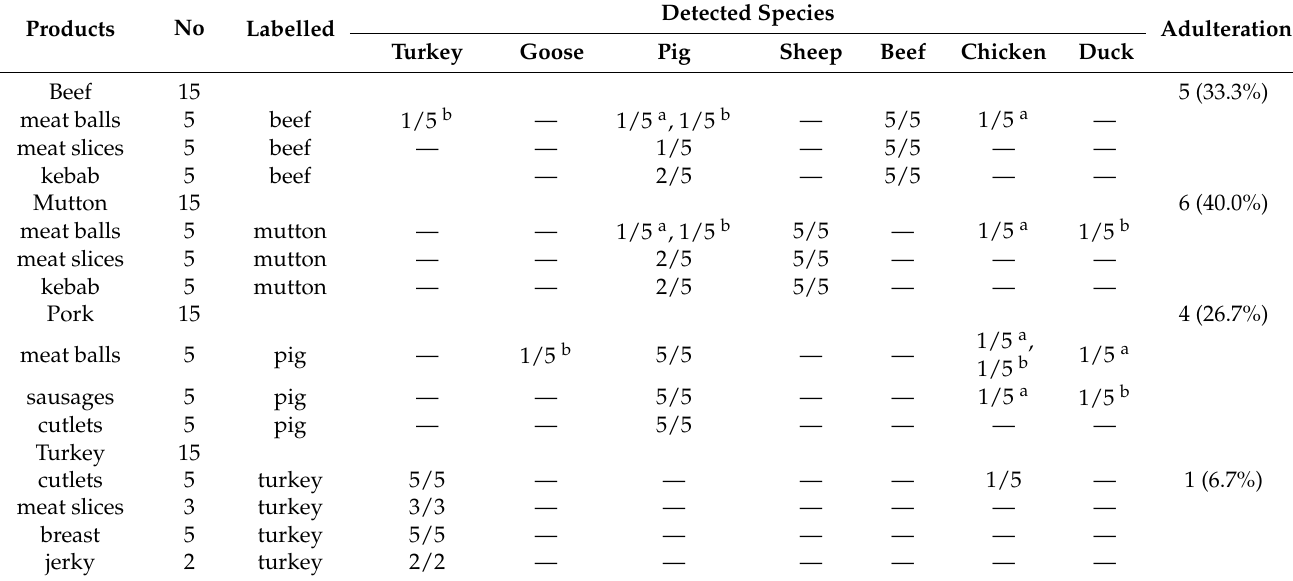
Table 2. Results of multiplex PCR assay performed on commercial meat